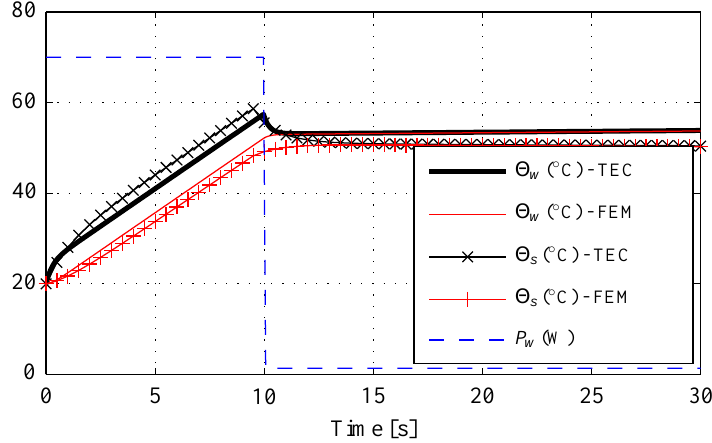
Figure 11. Motor winding and stator temperature dynamic responses for changing values of copper loss, at ambient temperature of 20 ◦